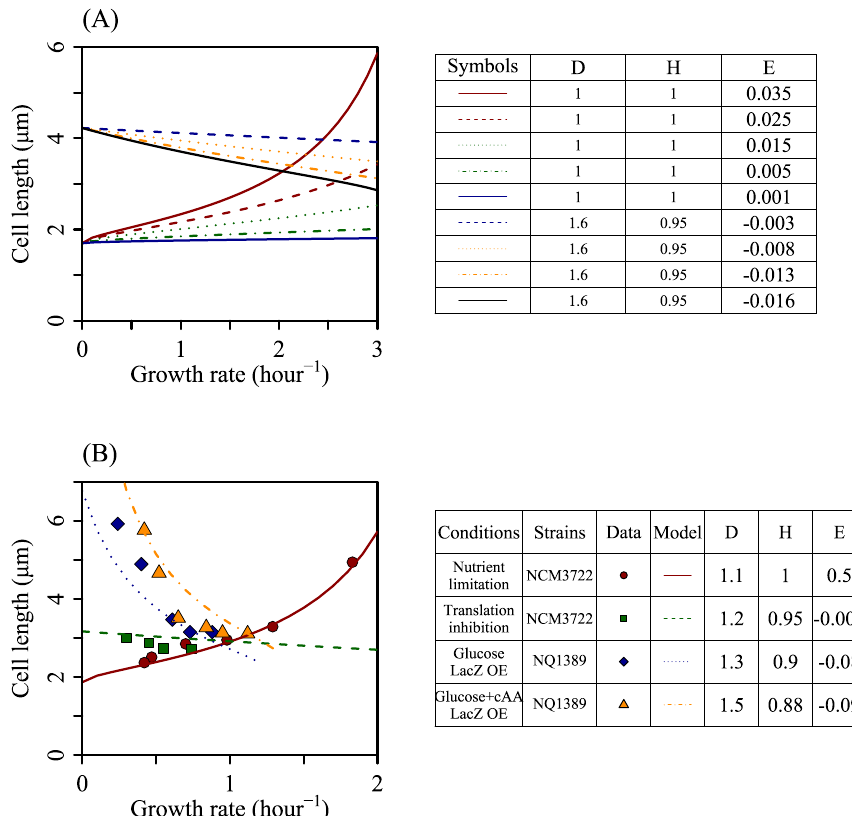
Figure 3. Three tendencies of cell length changing with growth rate. D is cell width. H = 1 − v 0 E = w CLPNS (See Equation (31)). E represents the correlation between the cardiolipin synthesis rate and V max growth rate. The reduced model of SEFBA is suitable to describe the changes of cell length with growth rate under various growth stresses. The parameter C in Equation (31) depends on f PG and K M . As both f PG and K M are about constant, the value of C is 2.96 under different growth stresses. ( A ) The lines display the relationship between growth rate and cell length under different stress conditions. Different types of lines were drawn with different parameters written in the table beside. ( B ) Comparison of the reduced model and experiments. The experimental data were cited from Basan et at.